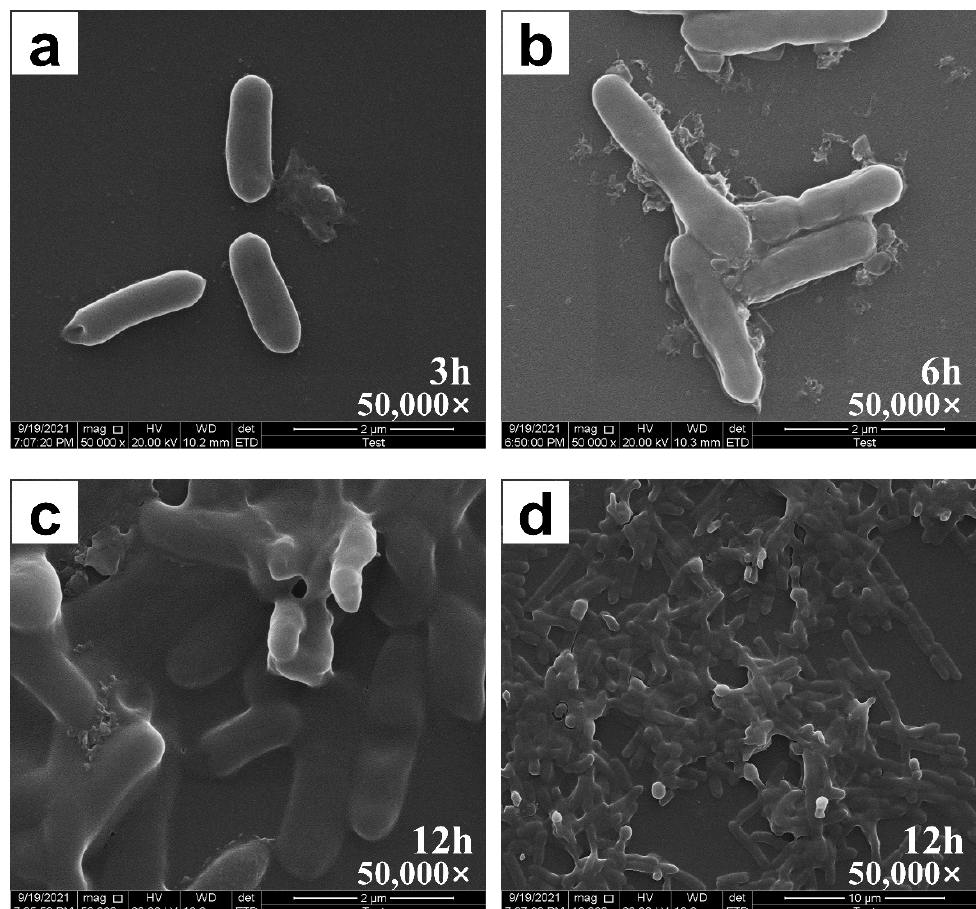
Figure 3. SEM diagrams of E. coli biofilm formation. ( a ) Biofilms cultured for 3 h (50,000 × ); ( b ) biofilms cultured for 6 h (50,000 × ); ( c ) biofilms cultured for 12 h (50,000 × ); ( d ) mature biofilms from a large perspective (10,000 × ). The incubation time was 12 h and no boron derivatives during this cul- tivation.